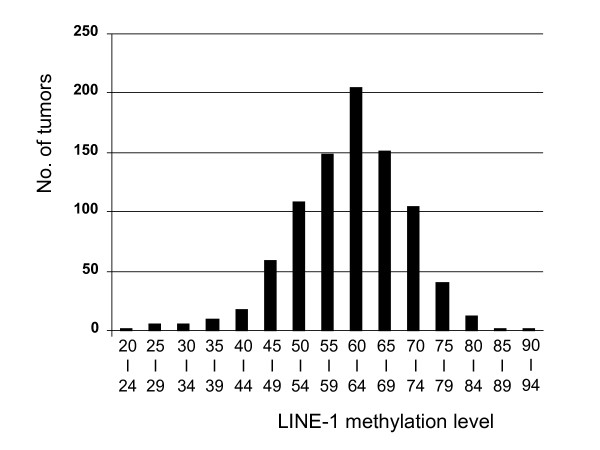
Distribution of LINE-1 methylation levels in 869 colorectal cancers. LINE-1 methylation levels distributed approximately normally, except for the presence of extreme hypomethylators (LINE-1 methylation value < 40), which appear to be separate from the remaining normal distribution.